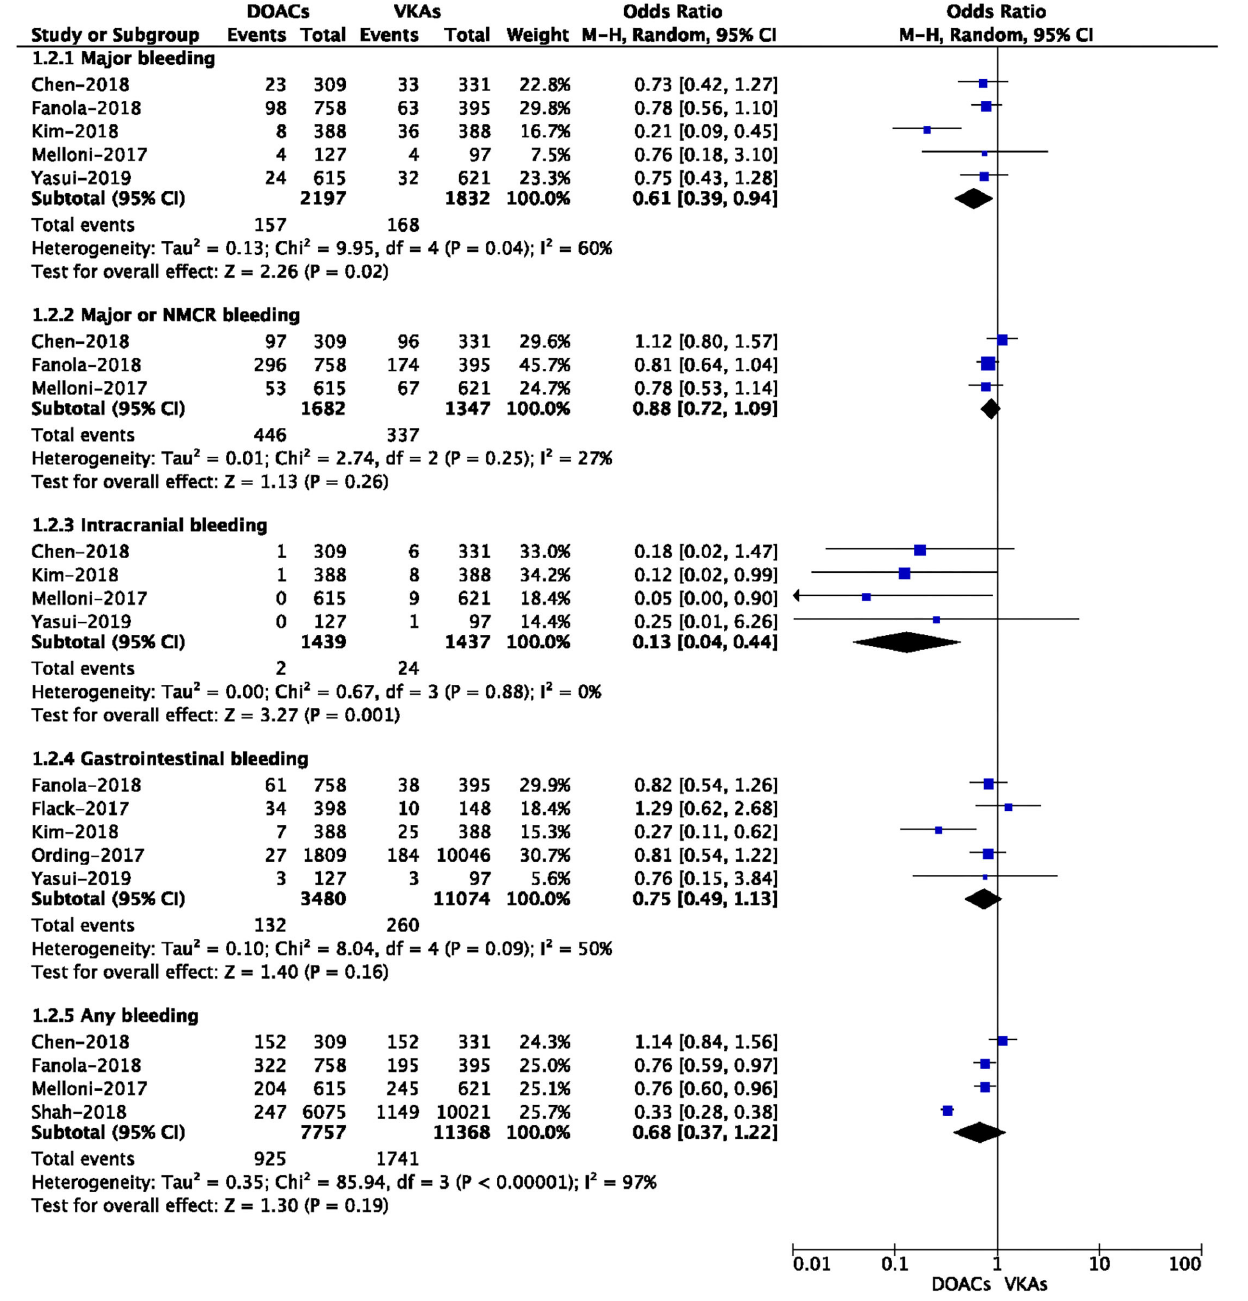
FIGURE 2 | Crude safety event rates of direct oral anticoagulants compared with vitamin K antagonists among atrial fibrillation patients with